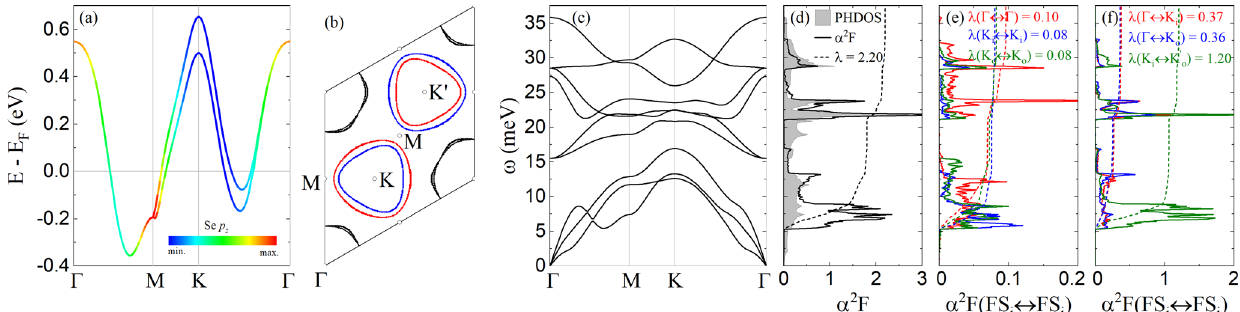
Fig. 1 Electron – phonon interaction and intra/inter-pocket Eliashberg spectral function. a Calculated band structure with SO coupling in monolayer NbSe 2 . The color along each band denotes the relative Se p z character according to the color bar. The orbital character is taken from a calculation without SO coupling. b Cross section of the Fermi surface with SO coupling in monolayer NbSe 2 . Red and blue dots at the K and K 0 contours denote spin-up and spin-down states. Here “ o ” and “ i ” stand for the outer and inner pocket around the corresponding point. Calculated ( c ) phonon dispersion, d phonon density of states, isotropic Eliashberg spectral function α 2 F ( ω ) and integrated EPC λ ( ω ). Decomposition of α 2 F ( ω ) and λ ( ω ) corresponding to ( e ) intra-pocket Γ − Γ (red), K i − K i plus K 0 scattering, and ( f ) inter-pocket Γ − K